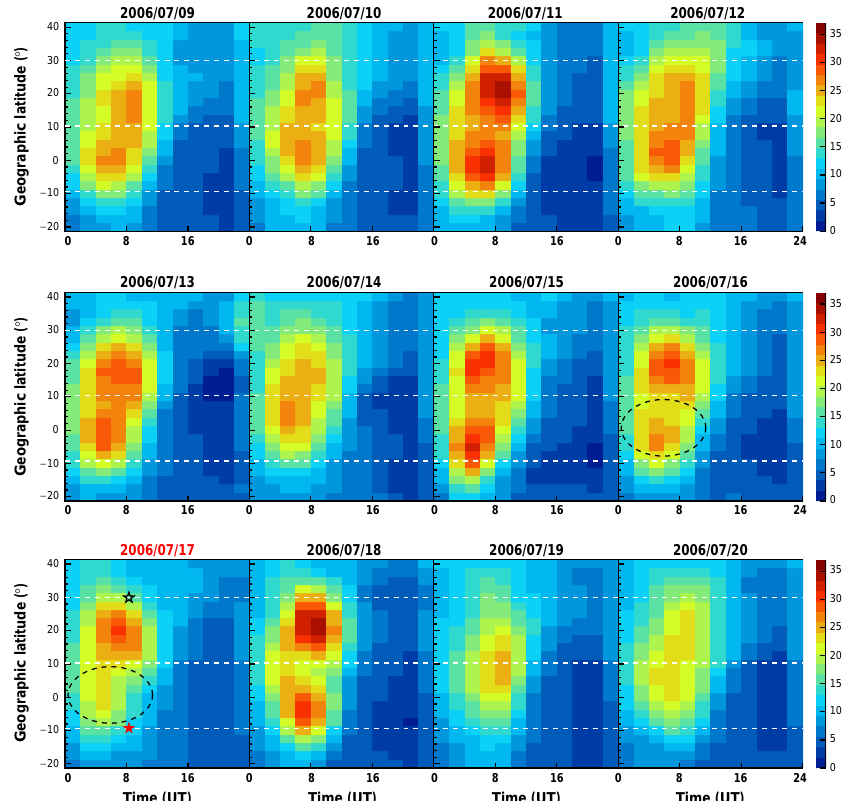
Figure 5. Latitude–time–TEC (LTT) plots along the earthquake longitude (107.42 ◦ E) extracted from the GIM during 9–20 July 2006. The solid and open star symbols are the epicenter and corresponding conjugate point of the south of Java earthquake, respectively. The three dashed white lines from the bottom to top denote magnetic latitudes of the epicenter, magnetic equator, and conjugate point, respectively. The two black dashed ellipses are the regions of anomalous “asymmetry” during the period of 02:00–10:00UT (09:00–17:00LT) on 16 and 17 July